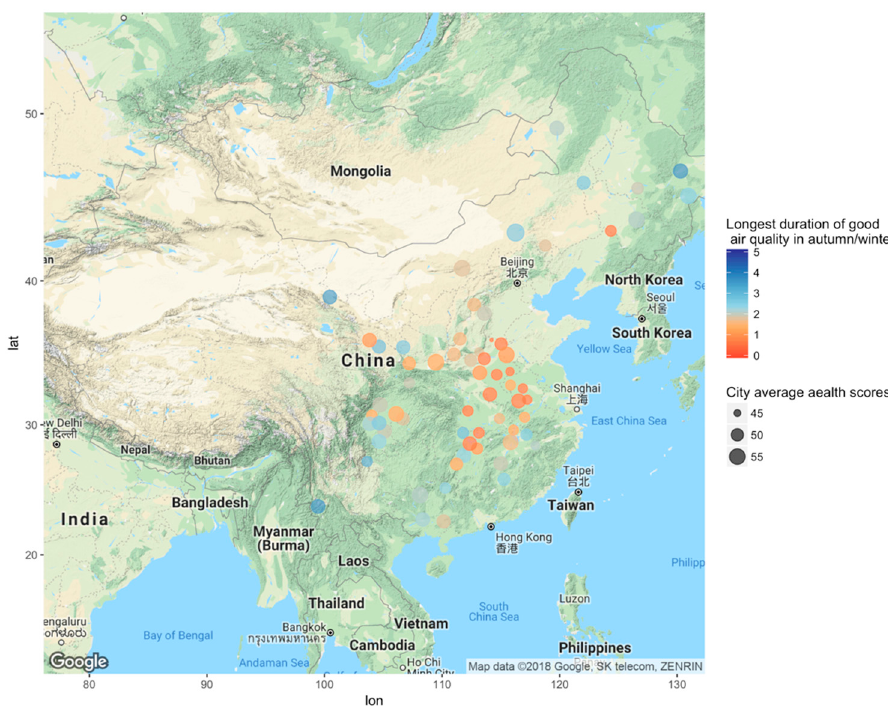
Figure 1. Correlation between health scores and longest duration of good air quality in autumn/winter in Central/Western China (The size of the dots represents population health in Central/Western China, and the color represents the longest duration of good air quality in autumn/winter in Central/Western China). Int. J. Environ. Res. Public Health 2018 , 15 , x 9 of 16